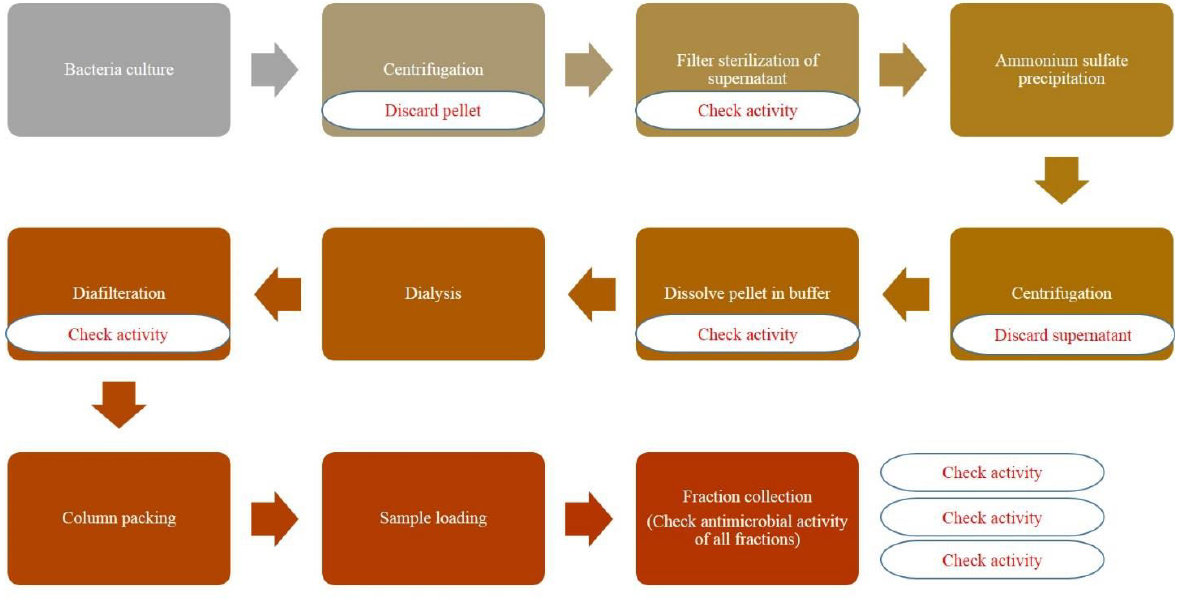
Figure 1: Flow chart of bacteriocin